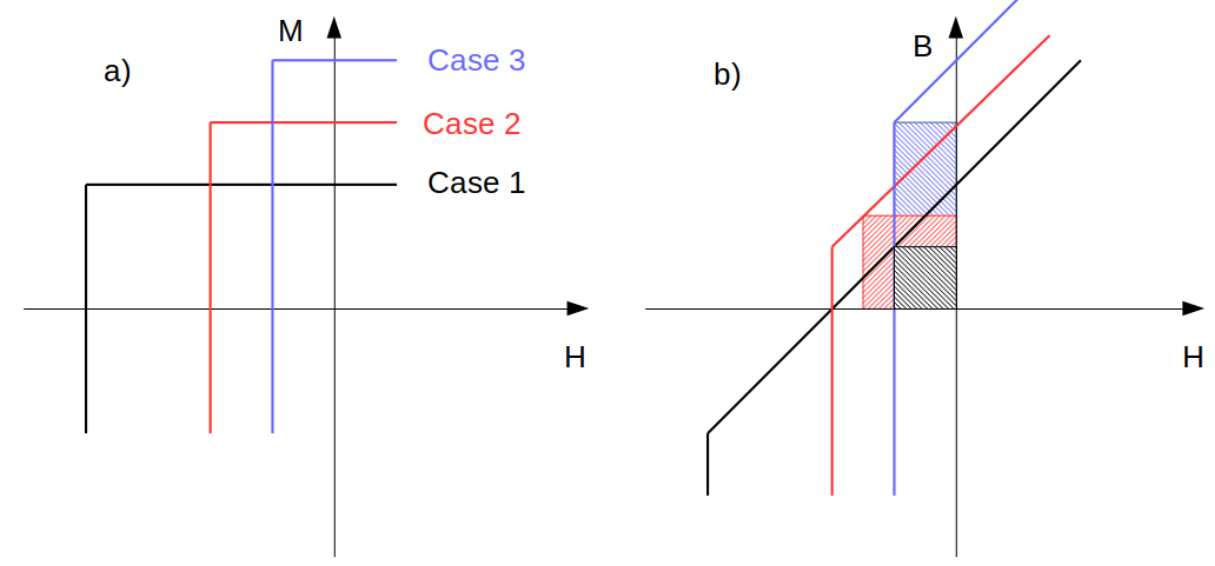
Figure 5. Impact of increasing the soft magnetic components on the M ( H ) and B ( H ) characteristics (see the text). The areas of crossed rectangles indicate the | BH | max parameters. ( a ) The M ( H ) curve ( b ) The B ( H ) curve